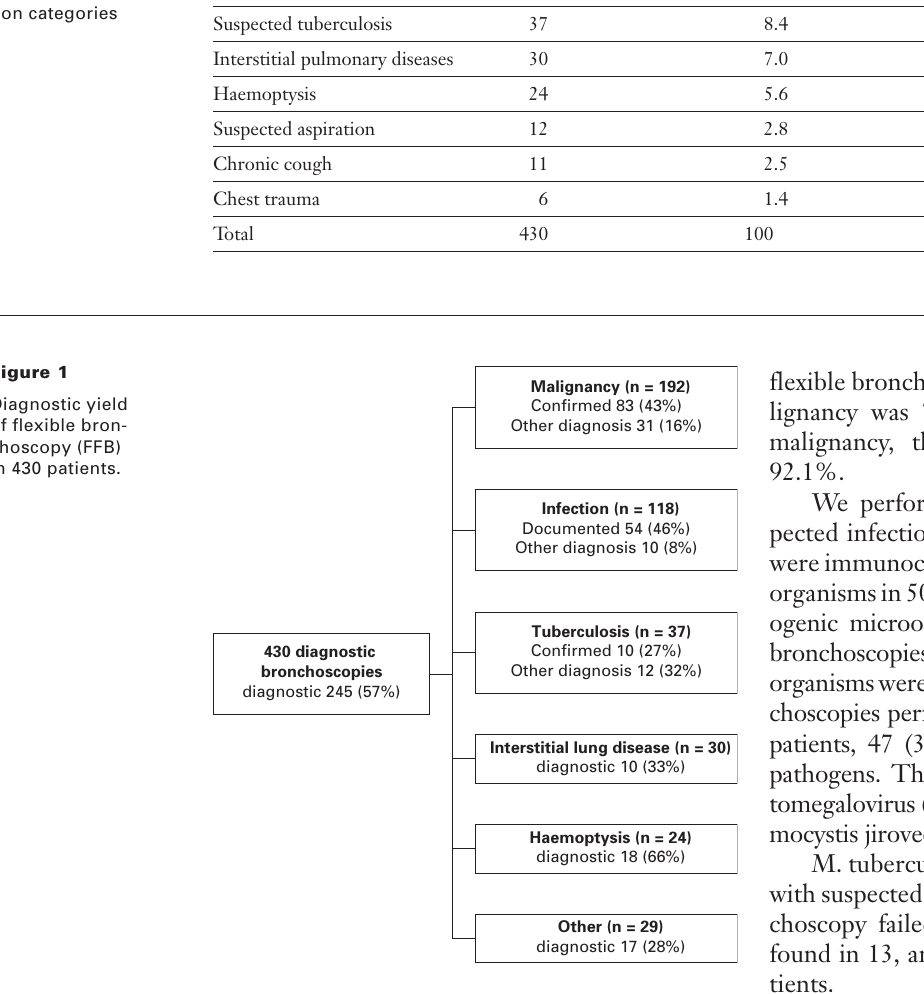
Overview of broncho- scopies performed for different indica- tion categories